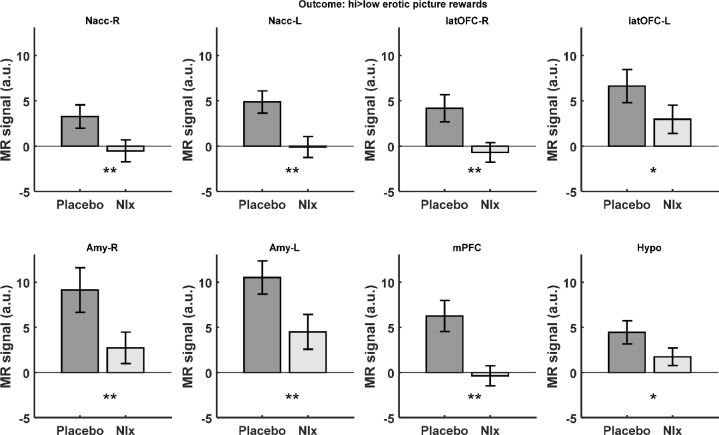
Region of interest contrasts of brain activity for high versus low erotic picture reward outcome for placebo and naloxone treatment.**p<0.05 corrected for multiple comparisons; *p<0.05 uncorrected.